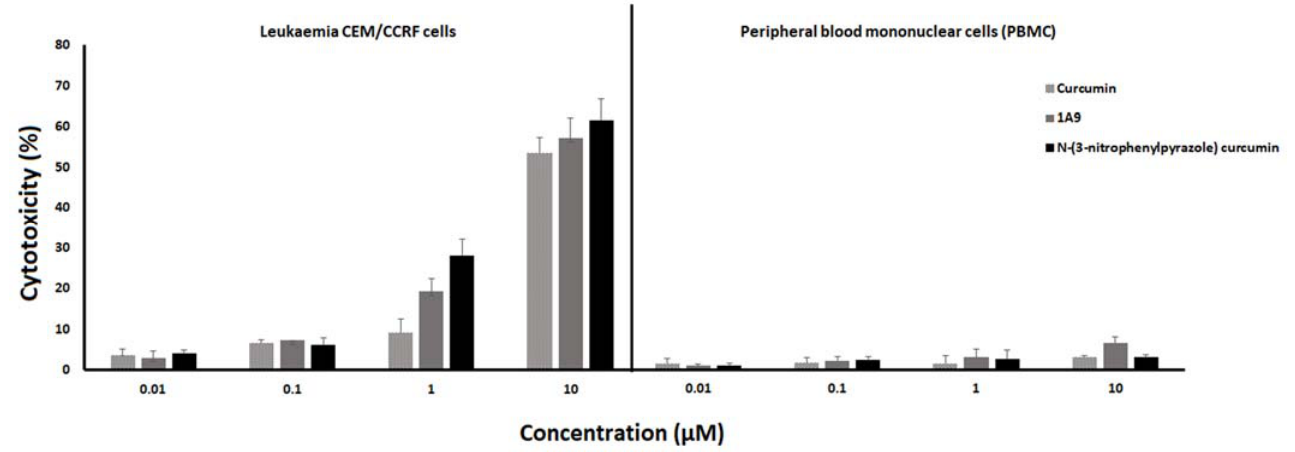
Figure 6. Cytotoxicity in CCRF-CEM leukemia cells (left) and peripheral blood mononuclear cells (PBMCs) of a healthy donor (right) by curcumin, 1A9, and N -(3-nitrophenylpyrazole) curcumin as determined by the release of lactate dehydrogenase. Cells were incubated with concentrations from 0.01 to 10 μ M and incubated at 37 °C for 48 h. DMSO was used as vehicle control. Mean ± SD of three independent measurements.